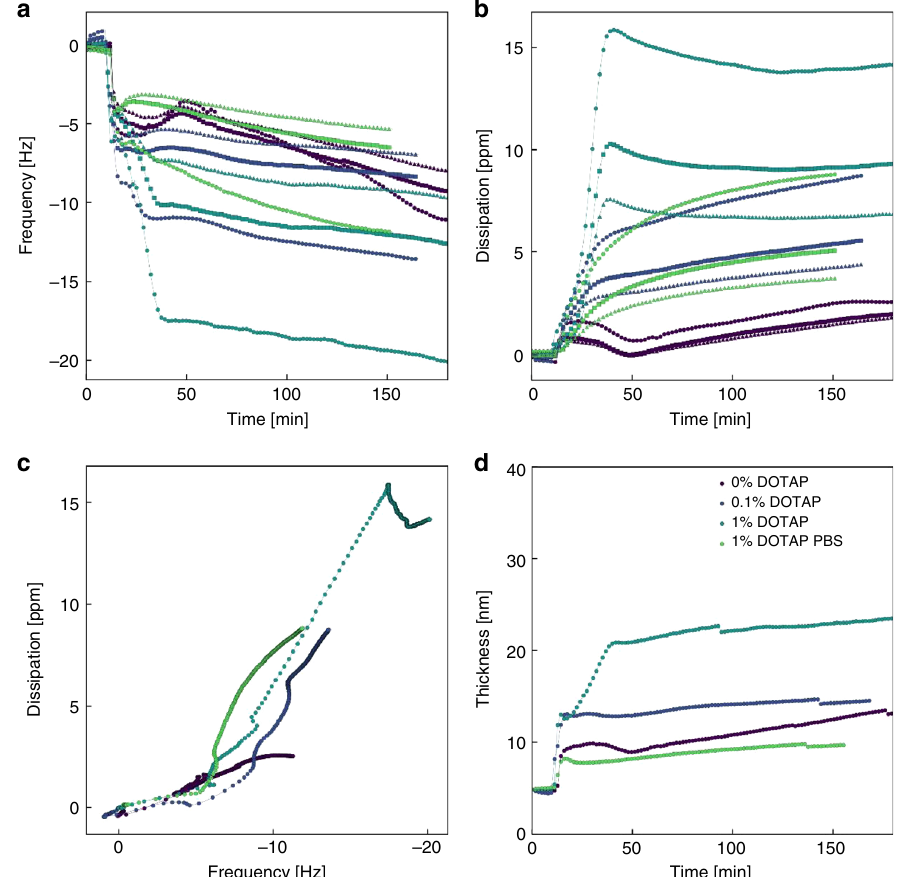
Fig. 6 Surface measurements during cubosome uptake measured by QCM-D. a Shift in frequency normalised by overtone ( Δ F/ n ) with time. b Shift in dissipation with time. The interaction of 40% DOPS bilayers with 0%, 0.1% DOTAP, 1% DOTAP in water and PBS are shown in purple, blue, light blue and green, respectively. The overtones n = 3, 5 and 7 are indicated by the circle, square and triangle symbols, respectively. c Plot of dissipation versus frequency for the 3rd overtone, n = 3. d Adhered fi lm thickness during cubosome adsorption estimated by Voigt model, using data from 3rd, 5th and 7th